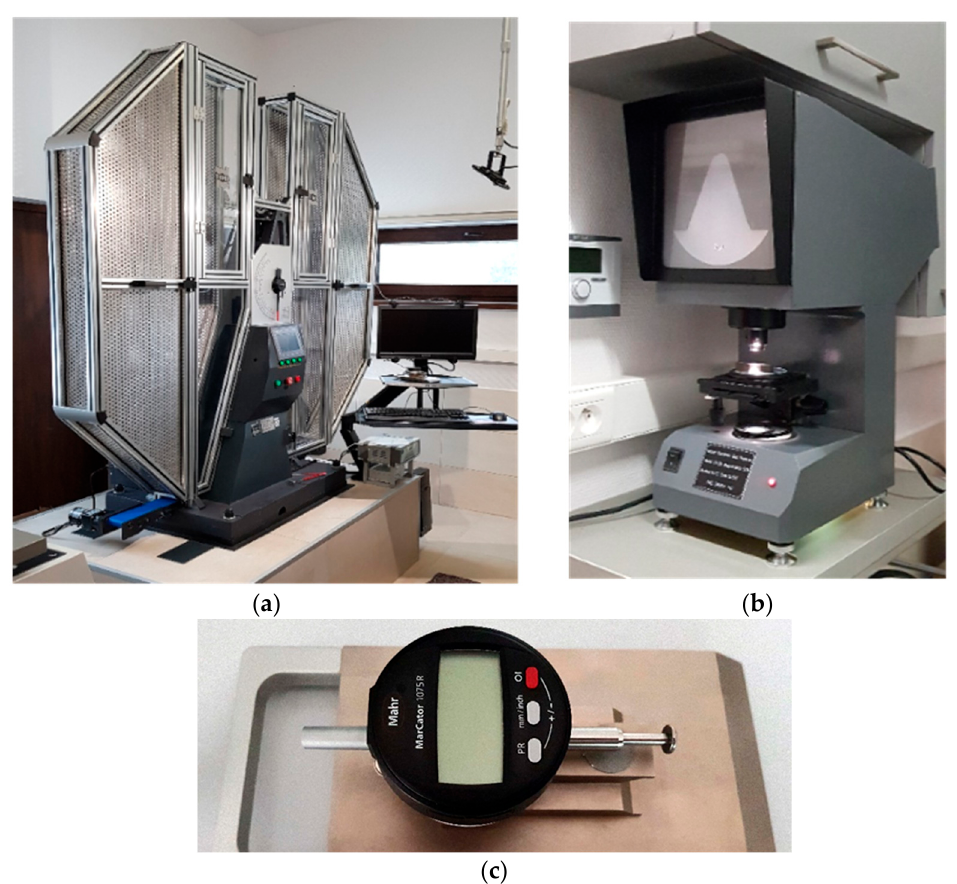
Figure 4. Testing equipment used during research: ( a ) instrumented Charpy hammer of the JB- W450E-L type, ( b ) XT-50 notch profile projector, ( c ) the gauge used to measure the lateral expansion of a sample (according to [7]).